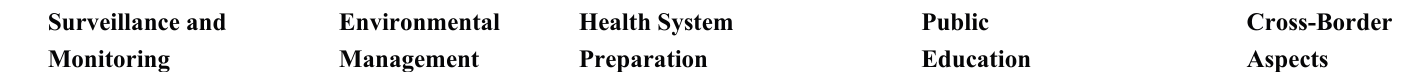
Table 1. VBD adaptation mechanisms in national adaptation plans and policies in Mediterranean